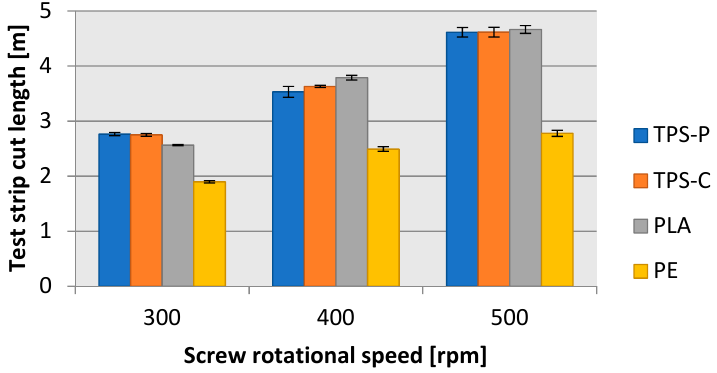
Figure 7. The appearance of the film made at a screw speed of 400 rpm: ( a ) LDPE, ( b ) PLA, ( c ) TPS-C, ( d ) TPS-P.